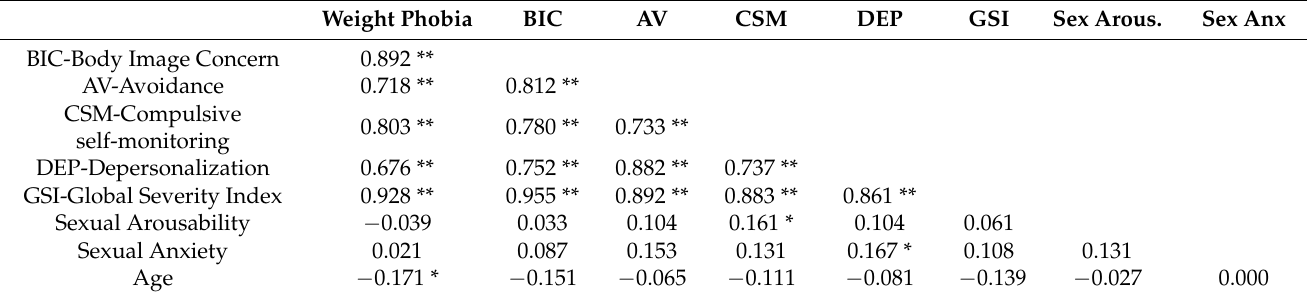
Table 4. Correlations between body image dimensions, arousal, and sexual anxiety in women before lockdown. Weight Phobia BIC AV CSM DEP GSI Sex Arous. Sex